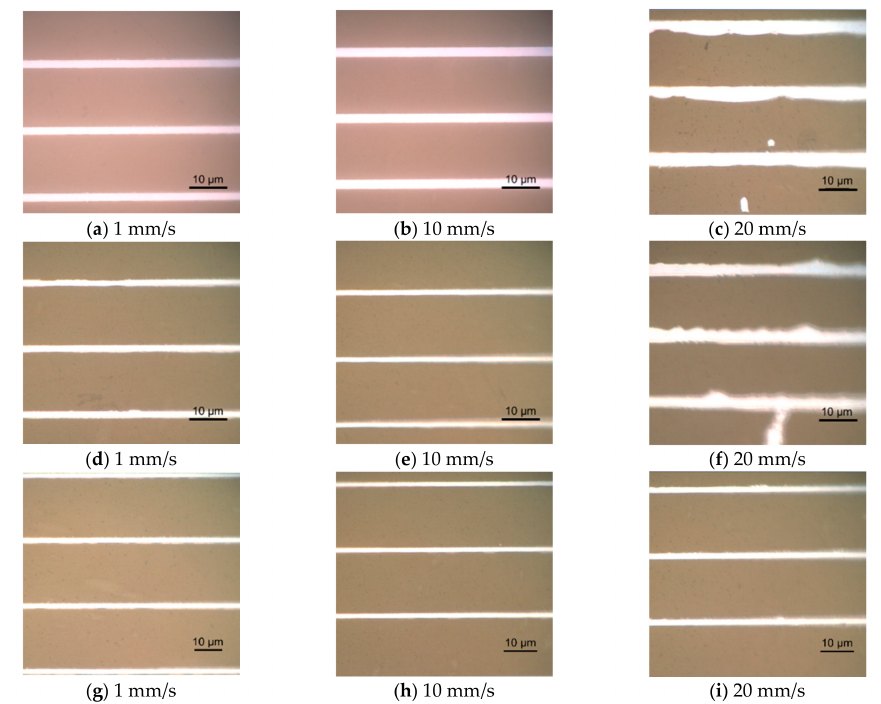
Figure 5. Results for printed pattern with 2- µ m line width in reverse offset printing: ( a ) 1 mm/s, ( b ) 10 mm/s, and ( c ) 20 mm/s printing speed using PUA1 (surface energy: 21.5 mN/m); ( d ) 1 mm/s, ( e ) 10 mm/s, and ( f ) 20 mm/s printing speed using PUA4 (surface energy: 30.5 mN/m); and ( g ) 1 mm/s, ( h ) 10 mm/s, and ( i ) 20 mm/s printing speed using PUA5 (surface energy: 79.1